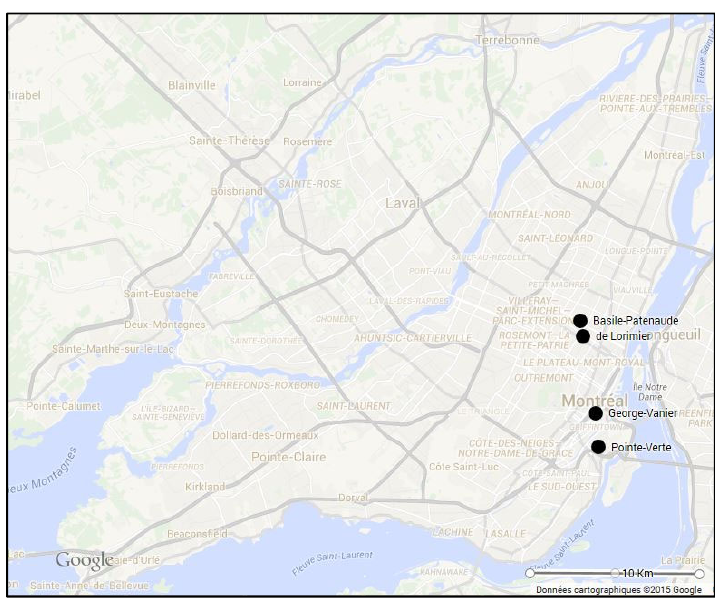
Figure 2. Map of Gardens Selected in Montreal